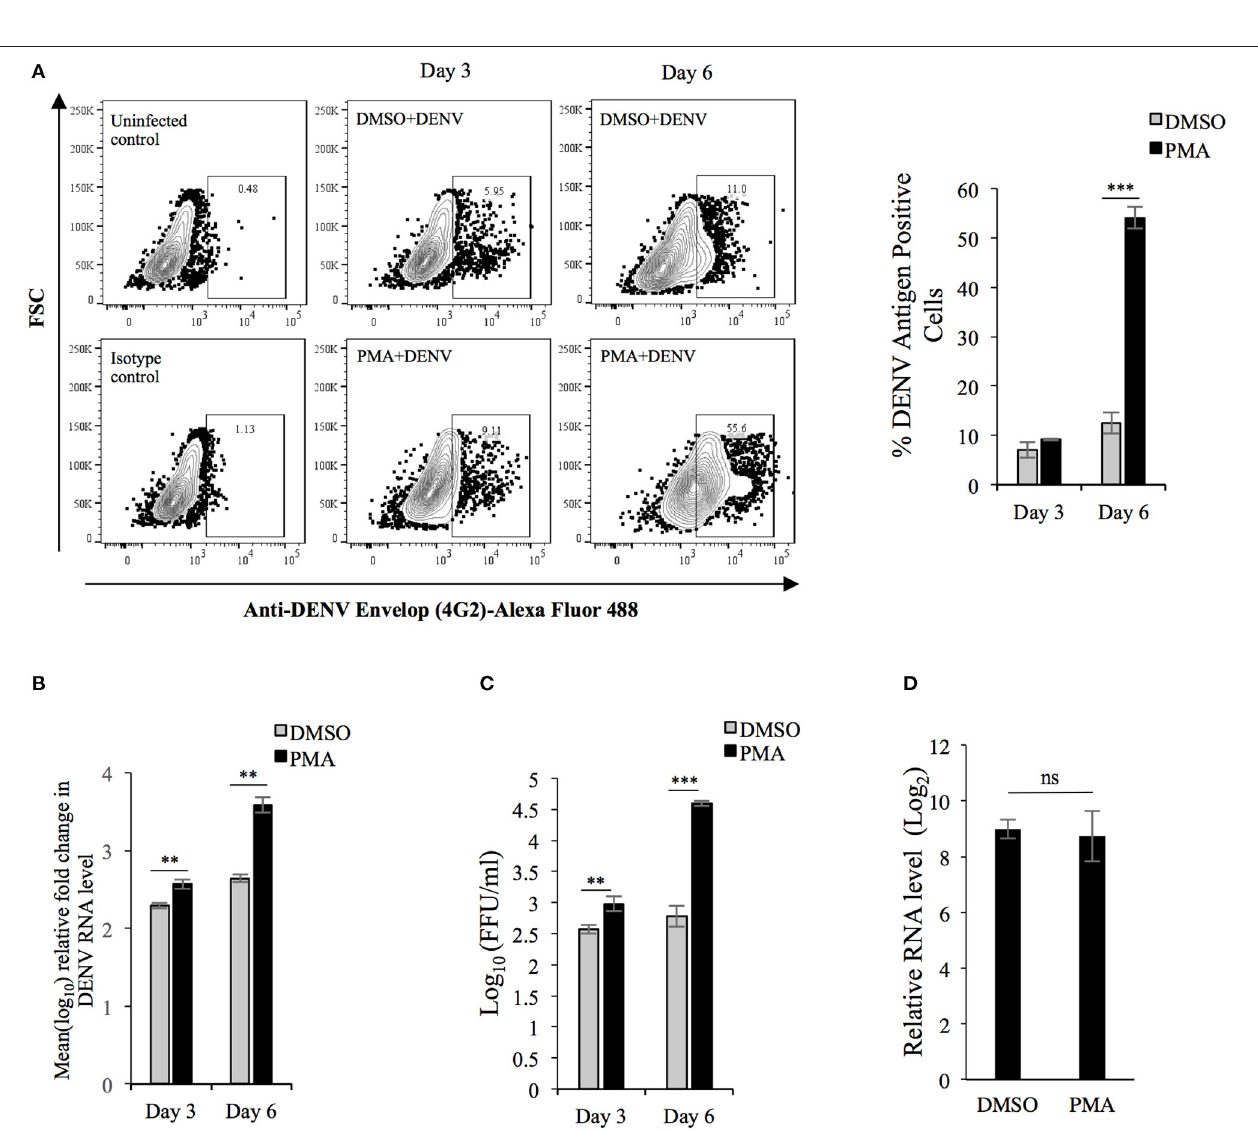
FIGURE 1 | value corresponding to each was normalized to that of GAPDH. The normalized value at day 0 was taken arbitrarily as 1 and those at day 3 and 6 expressed as fold-change with respect to that. For Panels A to E, the error bars represent standard deviation obtained from 3 independent experiments. The significance was calculated by Student’s t -test (*, ***, respectively, indicate P -values < 0.05 and < 0.001). (E) K562 cells treated with PMA for 0 or 3 or 6 days were fixed, permeabilized and stained for intracellular DNA using Propidium iodide (PI). The PI stain was quantified by flow cytometry and mean number of cells having ploidy of > 4N were plotted.